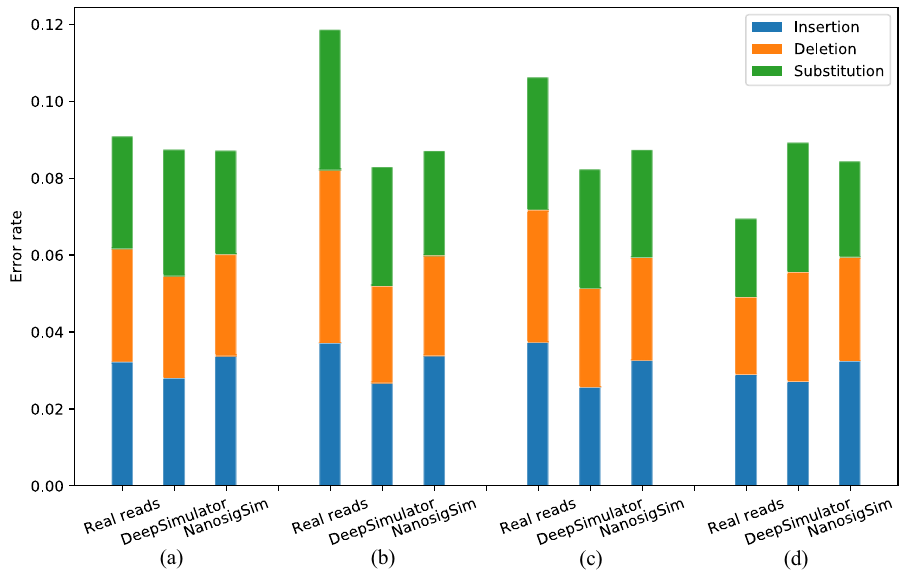
Figure 11. The profiles of different types of reads, tested on the four biological samples provided by the test dataset, which are basecalled using Guppy: ( a ) Acinetobacter pittii sample; ( b ) Klebsiella pneumoniae sample; ( c ) Serratia marcescens sample; and ( d ) Staphylococcus aureus